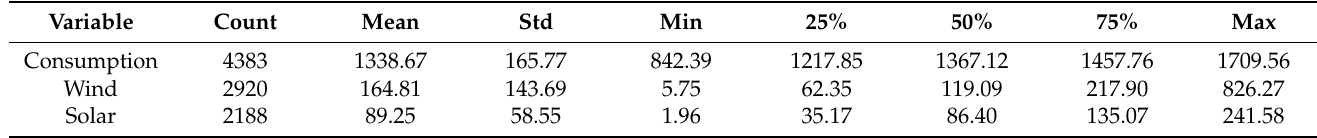
Table 2. Descriptive statistics of the